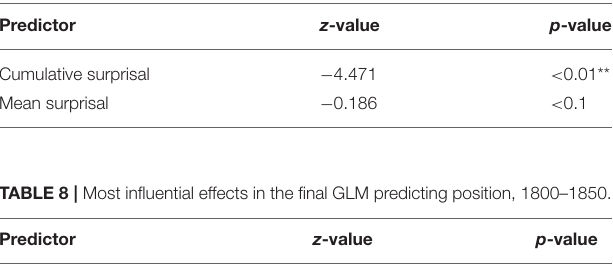
TABLE 9 | Most influential effects in the final GLM predicting position, 1850–1900.